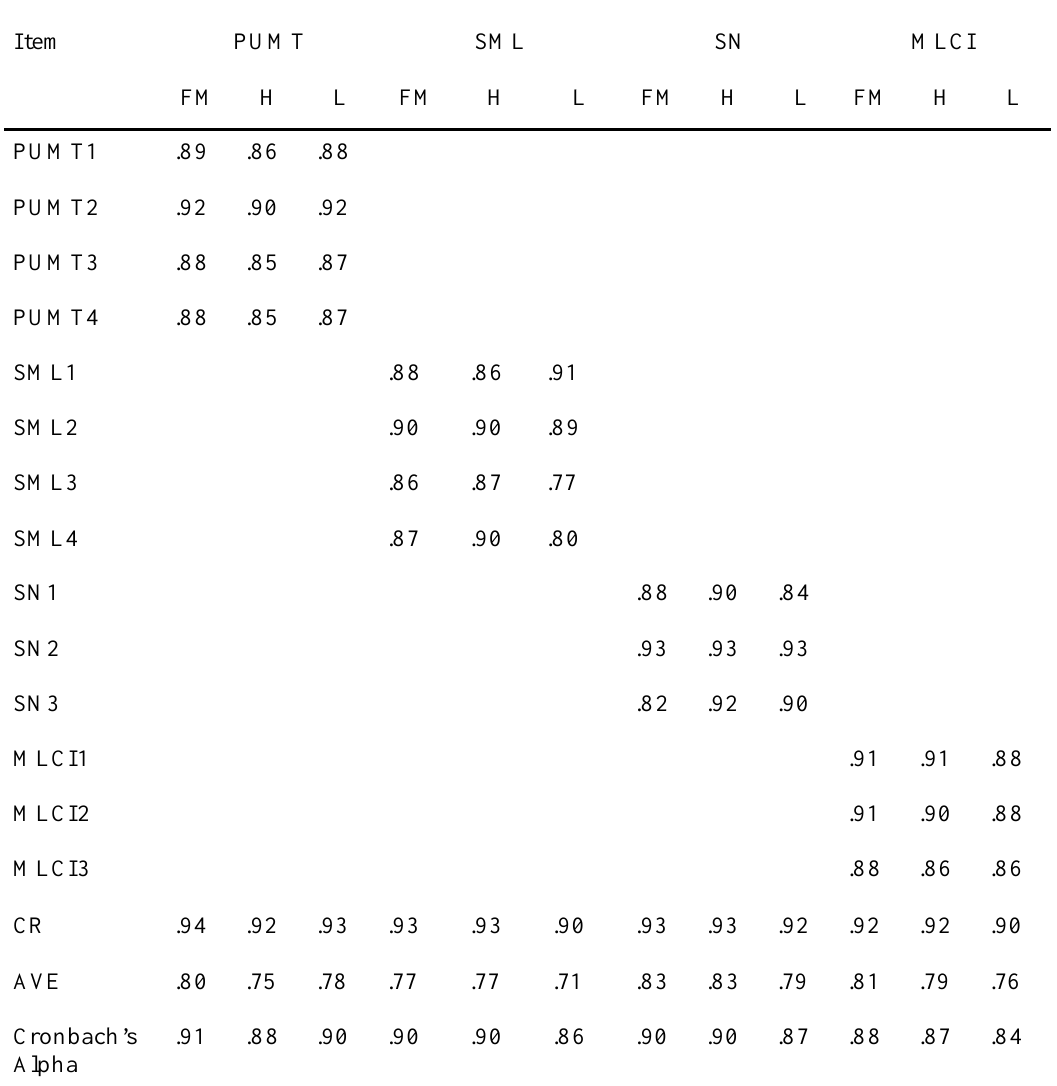
Table 2 Confirmatory Factor Analysis of Each Model